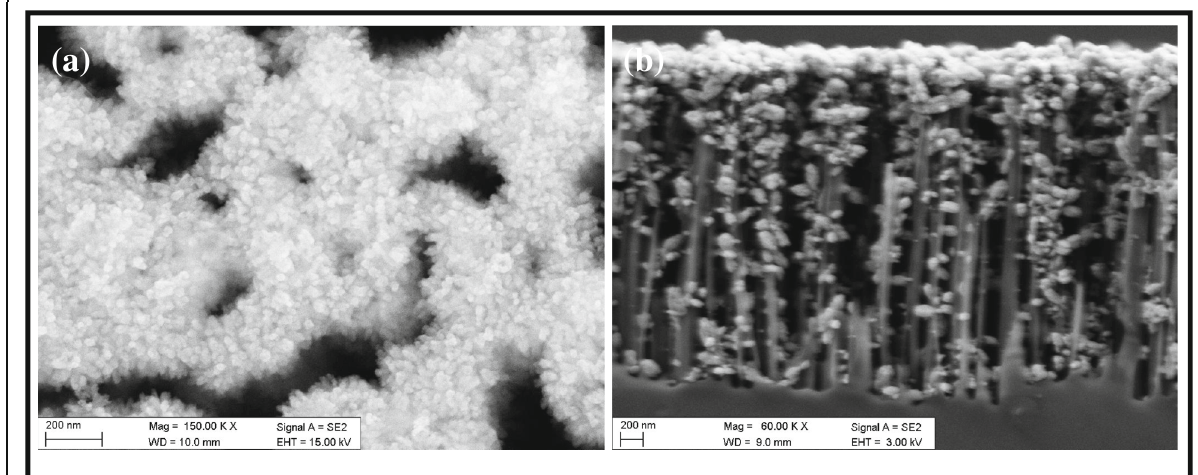
Fig. 3 SEM images of ZnO grown on silicon nanowires: a morphology and b cross